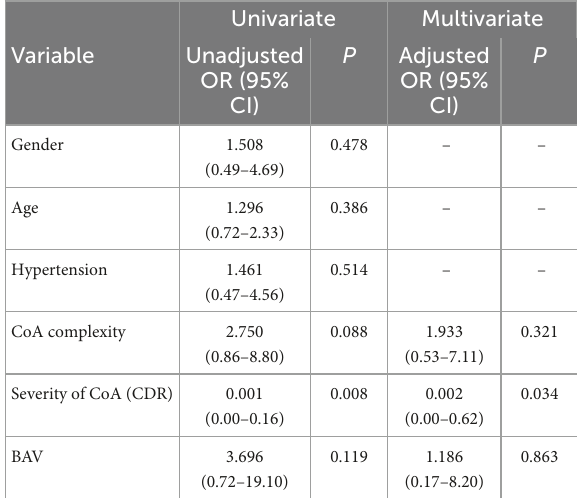
TABLE 4 Univariate and multivariate analyses for the presence of the ascending aortic